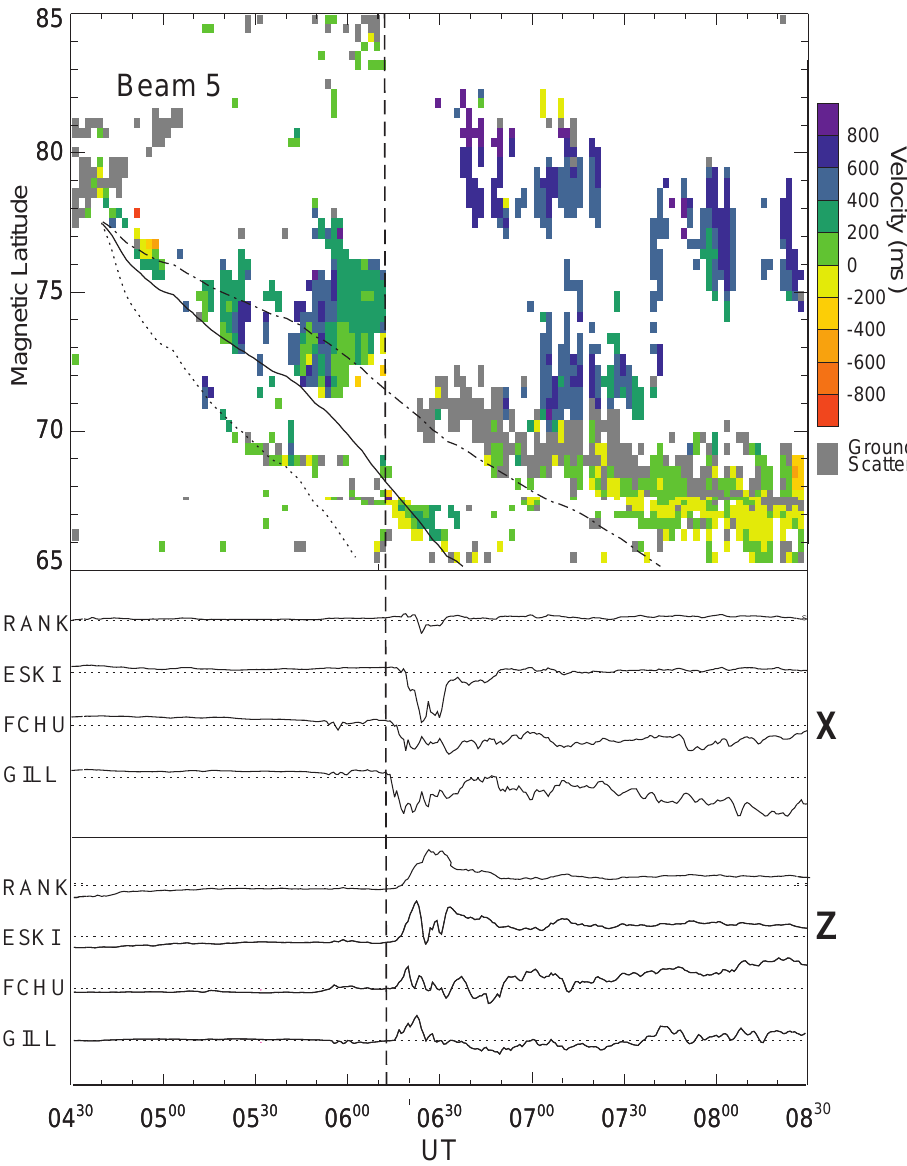
Fig. 7. LTV plot for beam 5 of the Saskatoon radar, 04:30 to 08:30UT. Overlaid is a black line showing the model calculations of where the equatorward boundary of the radar backscatter should lie, assuming an X -line length of 35 R E , and a constant offset of 4 ◦ from the polar cap boundary. The dot-dashed line is the model calculation of the location of radar backscatter for a latitudinal offset of 0 ◦ and a X -line length of 20 R E , while the dashed line models the location of radar backscatter for a latitudinal offset of 8 ◦ and an X -line length of 50 R E . The bottom two panels of the figure show the X and Z components of 4 magnetometers of the CANPOUS magnetometer